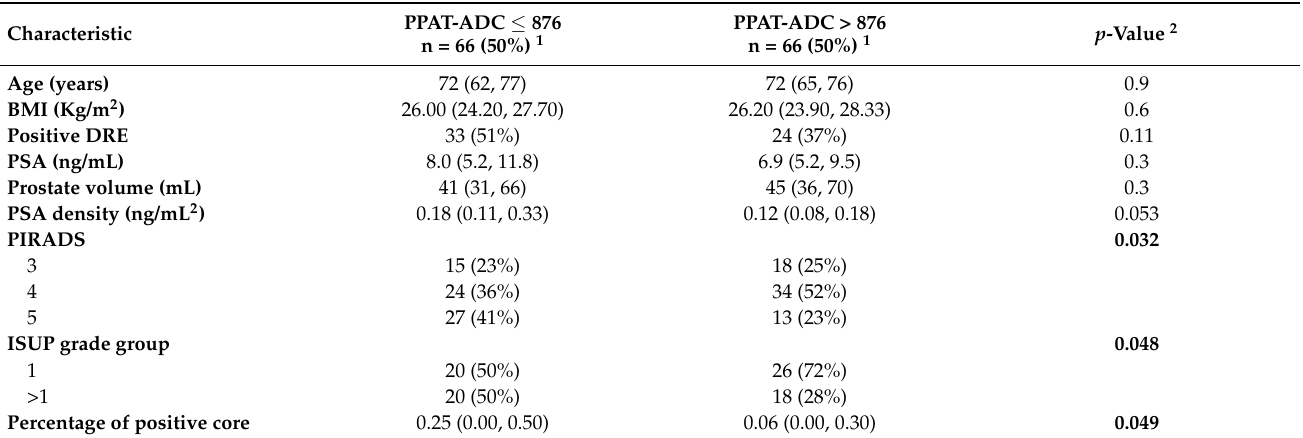
Table 2. Descriptive statistics of 132 patients who underwent prostate biopsy (PBx) for suspicion of clinical prostate cancer (PCa) with available multiparametric-magnetic resonance imaging (mp- MRI) data, stratified according to median peri-prostatic adipose tissue (PPAT)—apparent diffusion coefficient (ADC): up to vs. above the median.